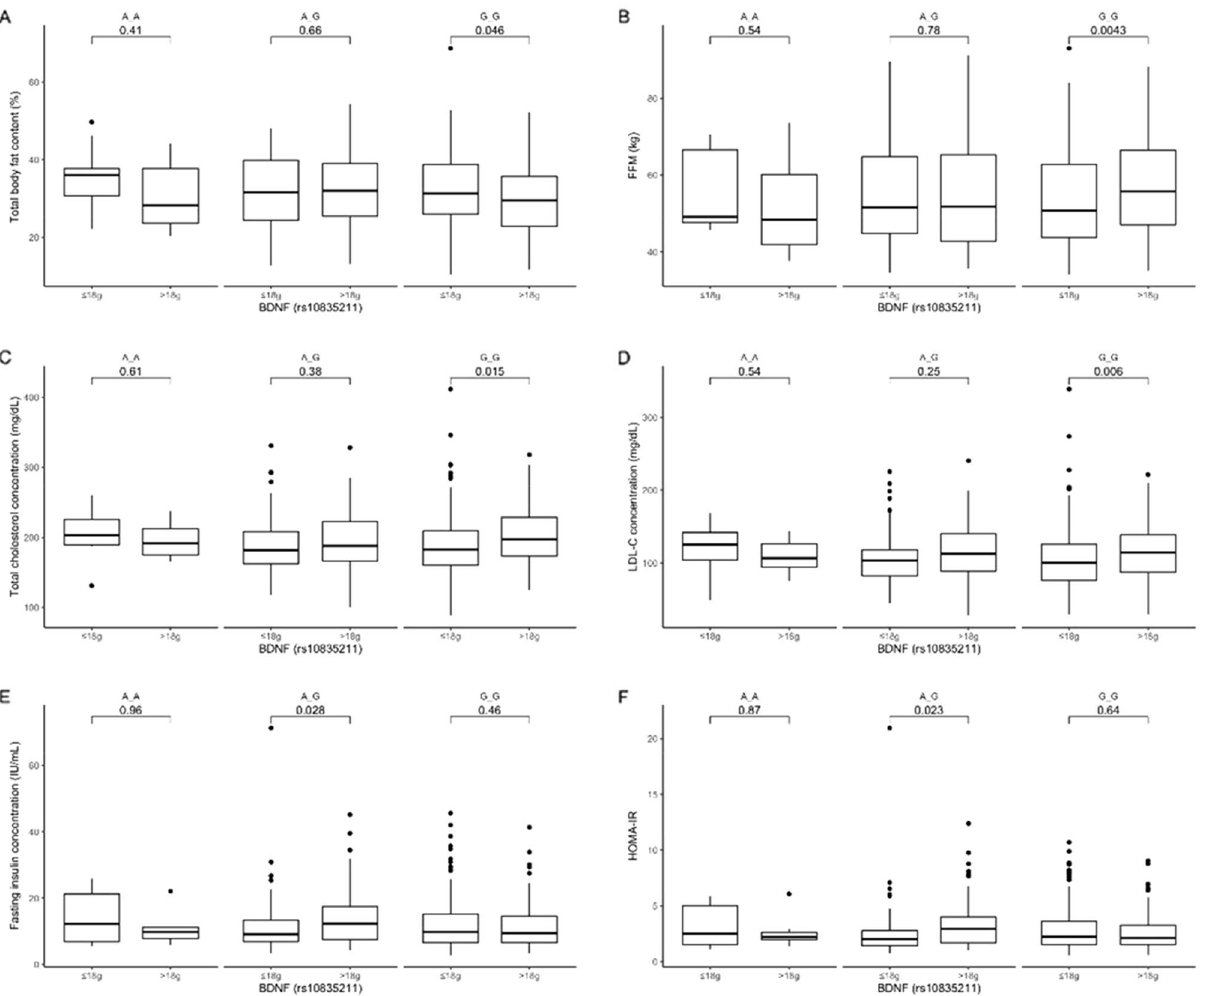
Figure 5. The ( A ) total body fat content (%); ( B ) FFM (kg); ( C ) total cholesterol concentration (mg/dL); ( D ) LDL-C concentration (mg/dL); ( E ) fasting insulin concentration (IU/mL); and ( F ) HOMA-IR in BDNF rs10835211 genotype carriers stratified by daily dietary fiber intake (≤ 18 g and > 18